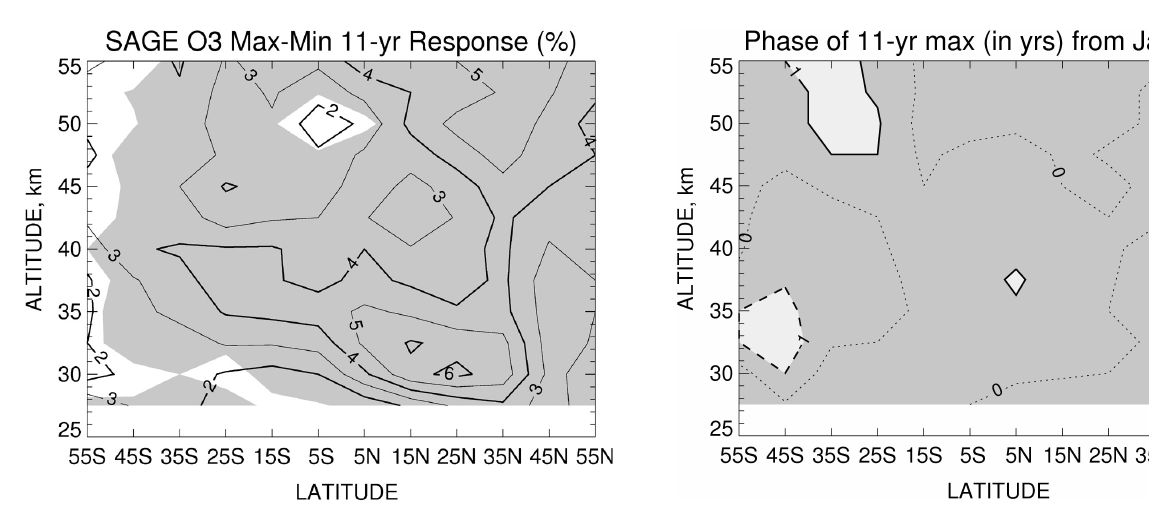
Fig. 6. Contour plot of the maximum minus minimum, 11-yr re- sponse (in percent) for the SAGE II ozone data of September 1991 through August 2005. Contour interval is 1.0%. Shading denotes where CI > 90% for the responses.